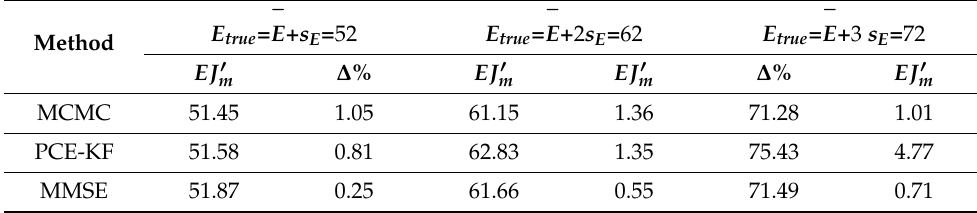
Table 9. Comparison of posterior mode E (cid:48) m and E true according to different updating procedures by measuring the fundamental natural frequency f 1